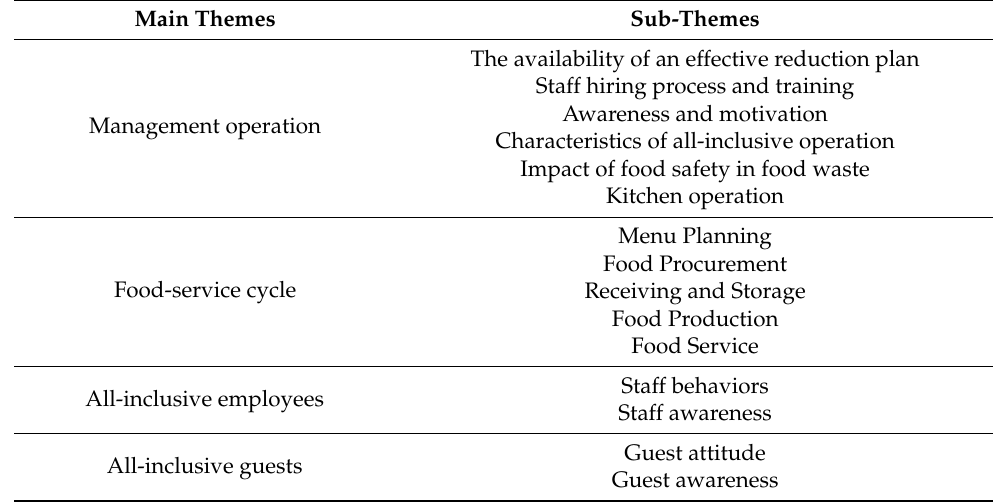
Table 1. Interview